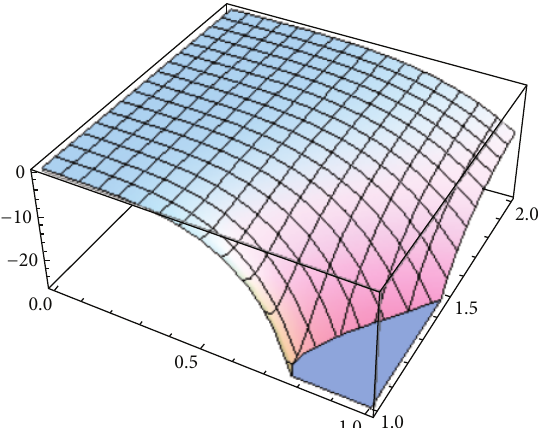
Figure 1: (𝑟 8 ⋆ /𝑅 6 )(4𝐴𝐶−𝐵 2 ) is plotted for AdS 5 black hole inside the horizon for which 0 ≤ 𝑛 < 1 and 1 < 𝑢 ≤ 2 .